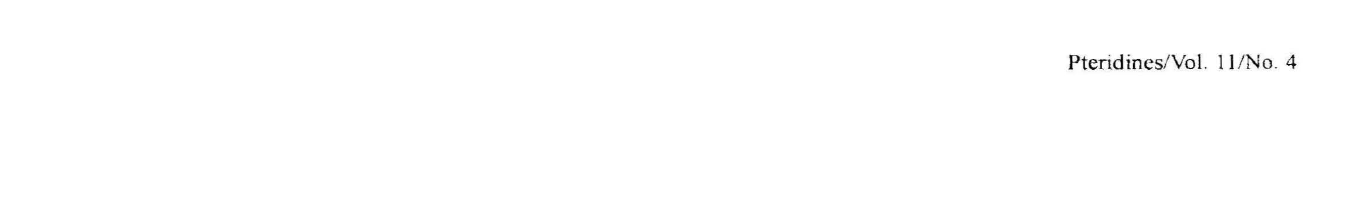
Fig.14. Concentrations (mean ± SD) of cholesterol and phospholipids, as well as fatty acid content in